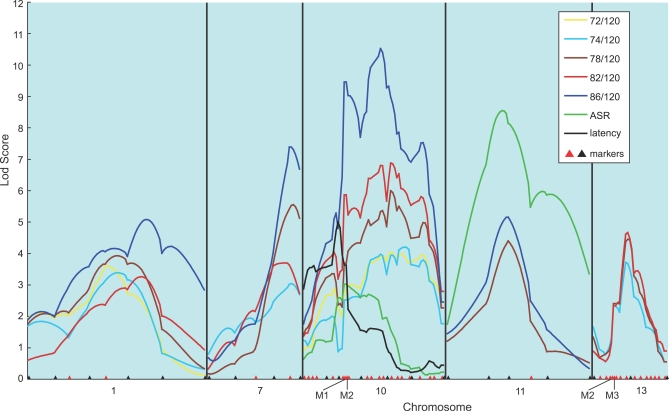
Dense Mapping in Female MiceThe results from the dense mapping of chromosomes in females that harbor significant QTLs detected in the second scan are shown. The chromosomes with lod scores not exceeding the threshold are eliminated. The positions of markers used in the first scan are indicated by black triangles, and those added in the second stage scan (‘dense') by red triangles. Analysis was performed using the MIM method. M1, rs33089794; M2, Cdh23 SNP; M3, Ofcc1 SNP; M4, Dtnbp1 SNP.